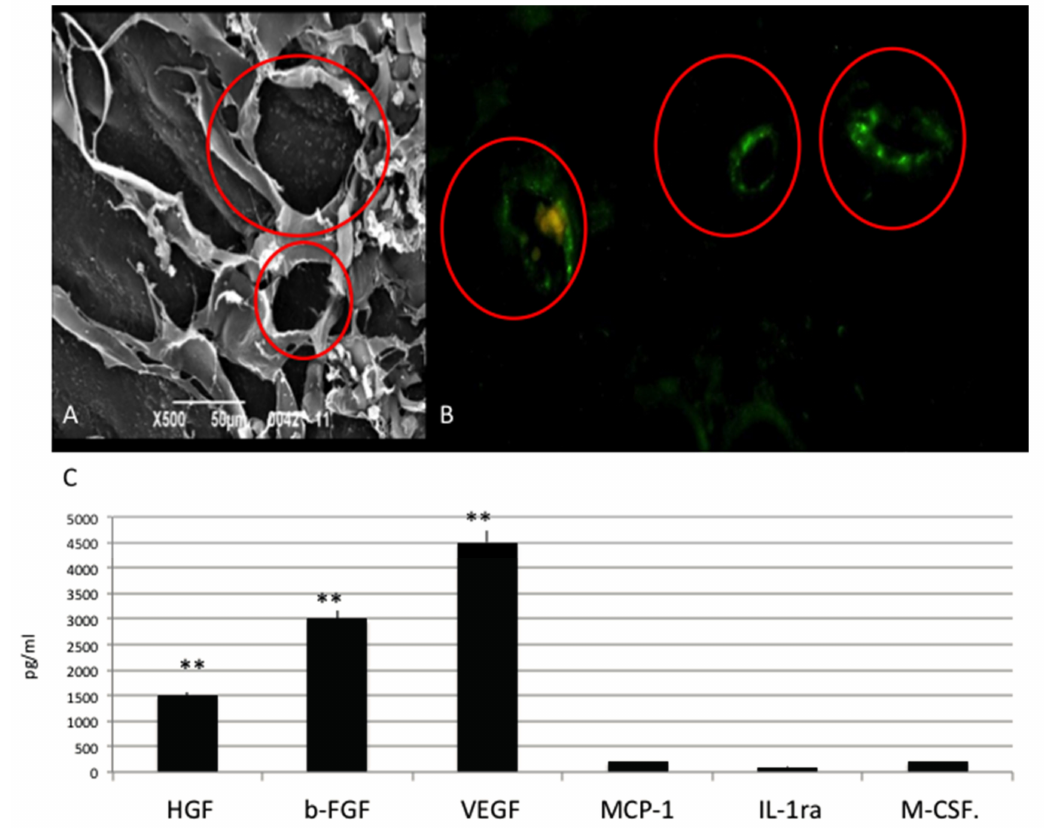
Figure 2. ( A ) SEM(scanning electron microscope ) analyses of HUVEC cultured onto Osteon Growth Induction (OGI) surfaces; ( B ) immunoistochemical test against CD31 (in green), capillary like structures (red circles) as SEM analyses revealed; ( C ) Quantification of growth factor release pg/mL. Statistically significant differences are indicated as ** p <